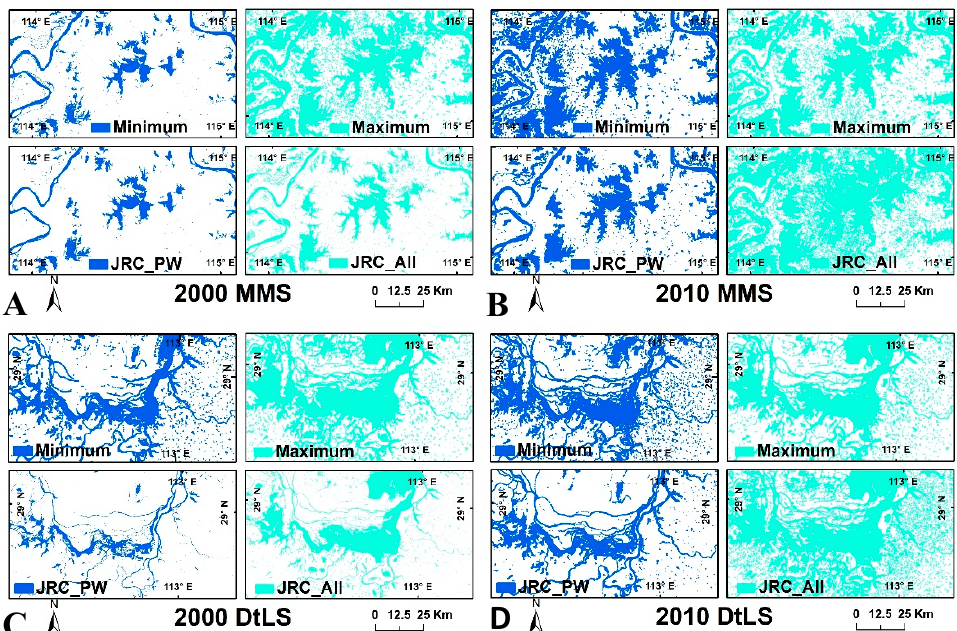
Figure 10. Comparisons between our results and Joint Research Centre (JRC) Yearly Water Classification History (Minimum represents minimal surface water, Maximum represents maximal surface water, JRC_PW represents permanent surface water of the JRC Yearly Water Classification History, and JRC_All represents the sum of the annual seasonal surface water and permanent surface water.). ( A ) Two results in the typical area of the Middle Mainstream Section (MMS) in 2000. ( B ) Two results in the typical area of the MMS in 2010. ( C ) Two results in the typical area of the Dongting Lake Section (DtLS) in 2000. ( D ) Two results in the typical area of the DtLS in 2010.